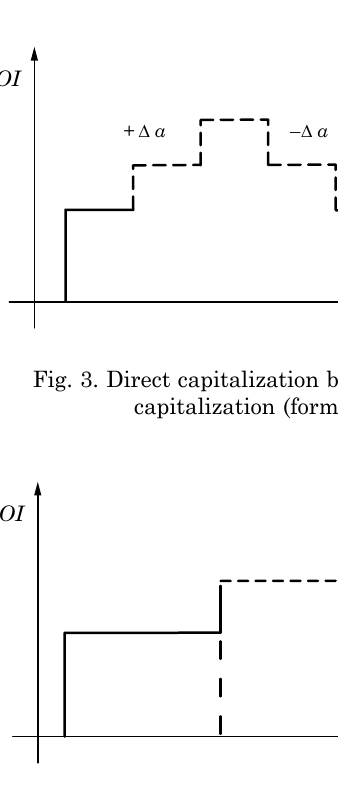
fig. 4. Direct capitalization based on cyclical capitalization (formula